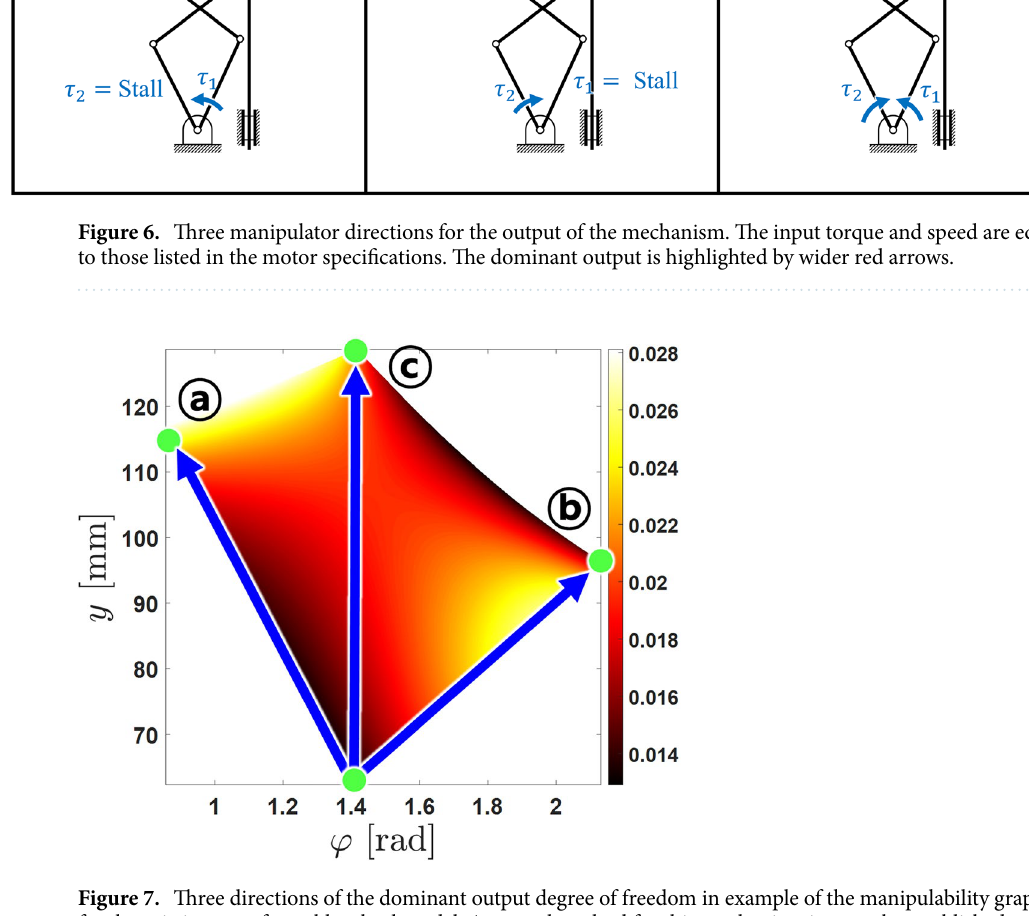
Figure 7. Three directions of the dominant output degree of freedom in example of the manipulability graph for the existing transformable wheel model. A control method for this mechanism is yet to be established, therefore manipulation is simple straight line through the